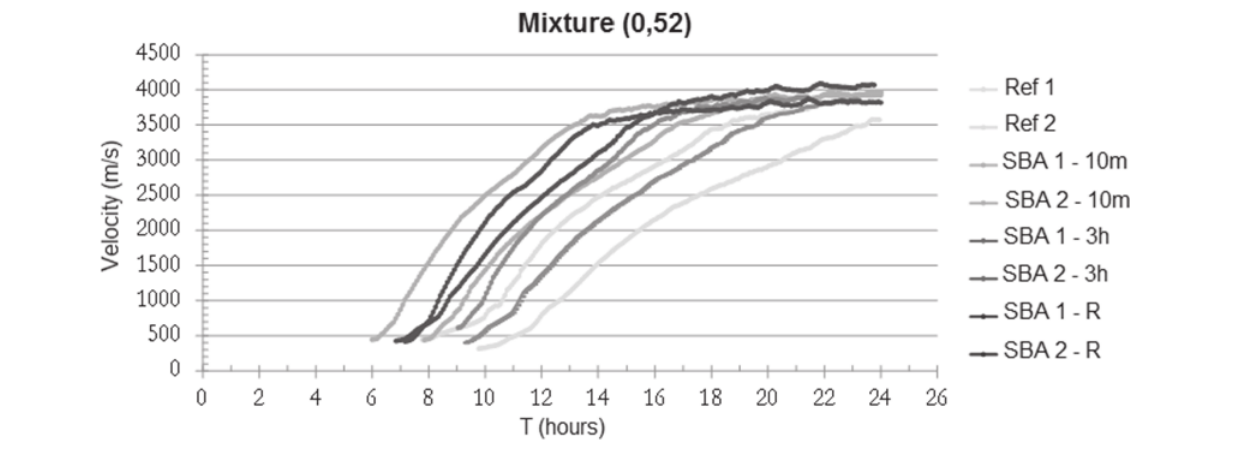
Figure 9 – Development of ultrasonic pulse velocity over the time for mixtures with w/c =